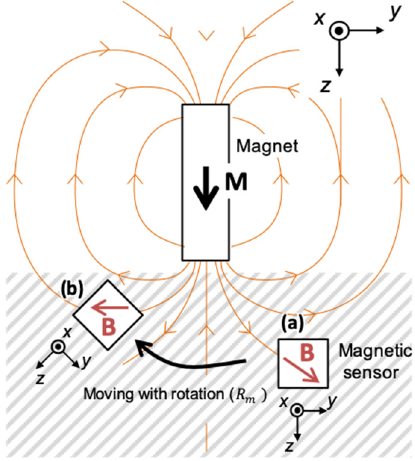
Figure 1. Principle of positional estimation.